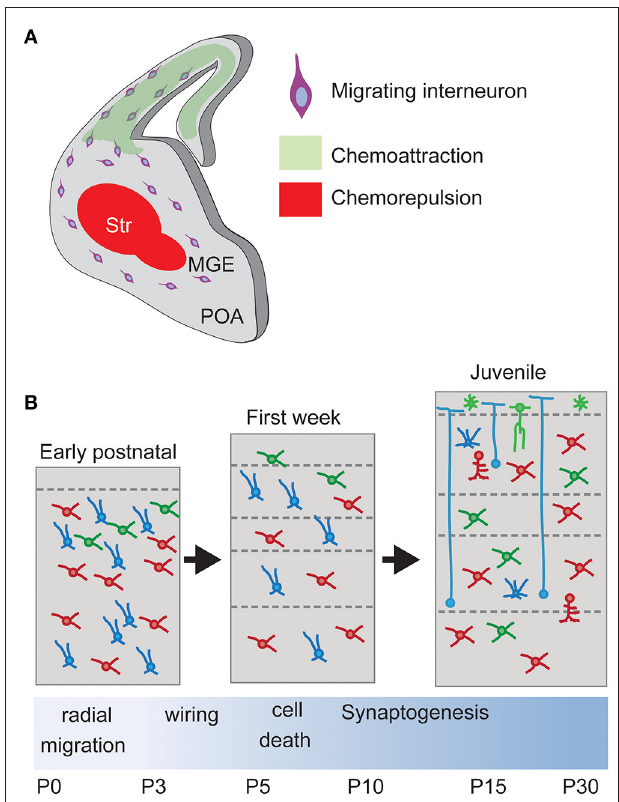
FIGURE 4 | Interneuron migration and integration. (A) Upon born, non-mitotic cortical Interneurons migrate through the subpallium avoiding entering the Striatum, a restrictive area due to chemorepulsive cues, and following a chemoattractive gradient of cues until reaching the final positioning in the cortex. Str, striatum. (B) Laminar allocation and integration into cortical circuits. During the first week, Interneurons allocate into their final laminal position following a period of programmed cell death. Surviving neurons develop synapses according to their type onto Pyramidal Neurons.